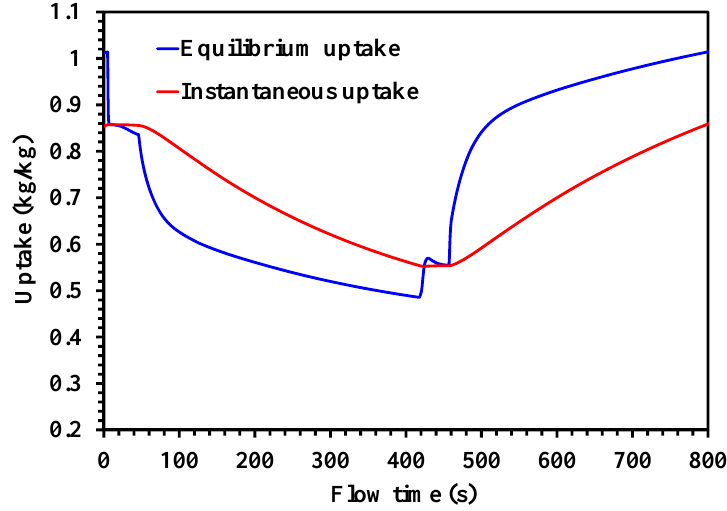
Figure 8. Simulated average instantaneous (red) and equilibrium (blue) uptakes in the